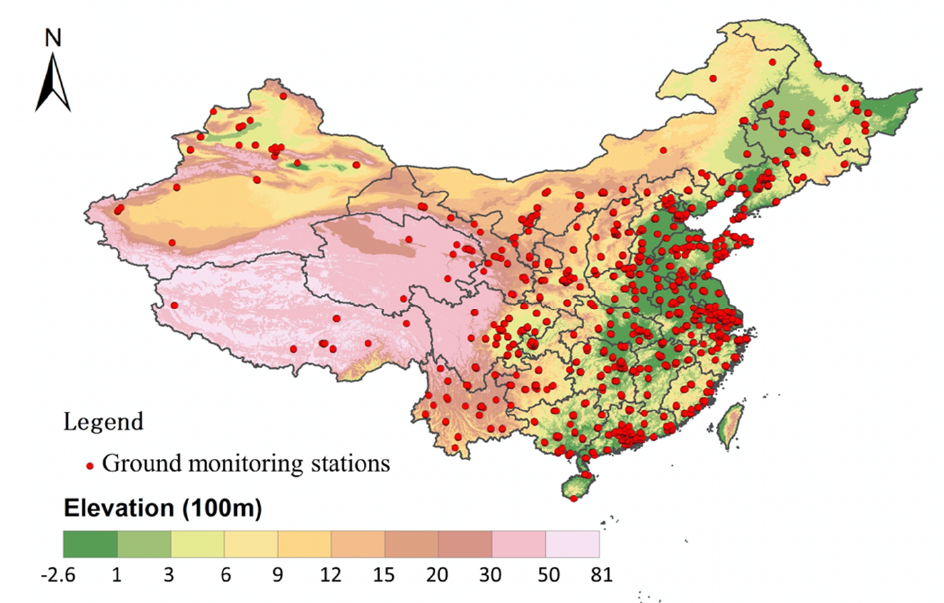
Figure 1. Map of the study domain. Ground monitoring stations are shown as red spots. China map with province outlines was downloaded from http://www.resdc.cn/, accessed on 20 March 2021, and the elevation data were obtained from the Advanced Spaceborne Thermal Emission and Reflection Radiometer (ASTER) Global Digital Elevation Model (GDEM) version 3.